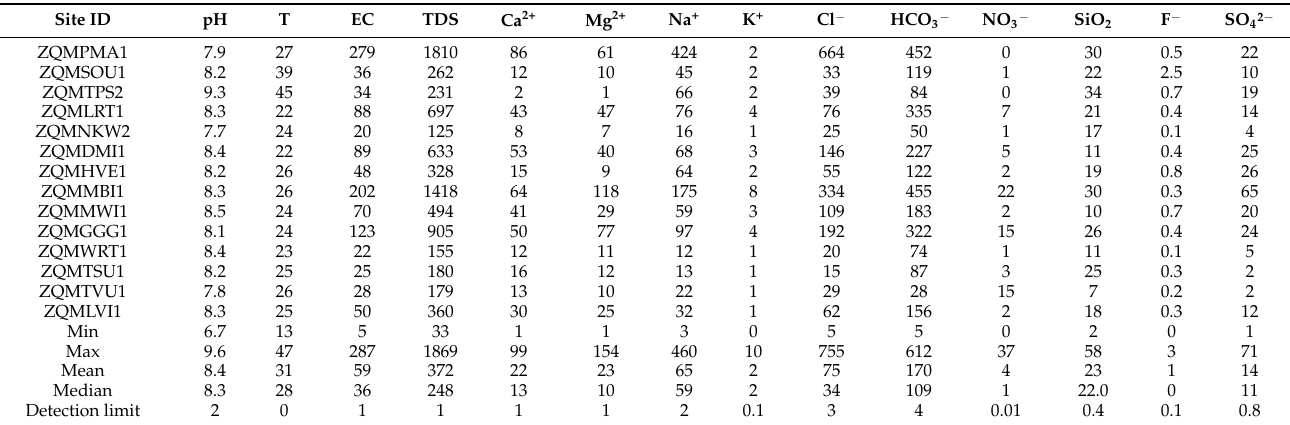
Table 1. Physico-chemical results used for various